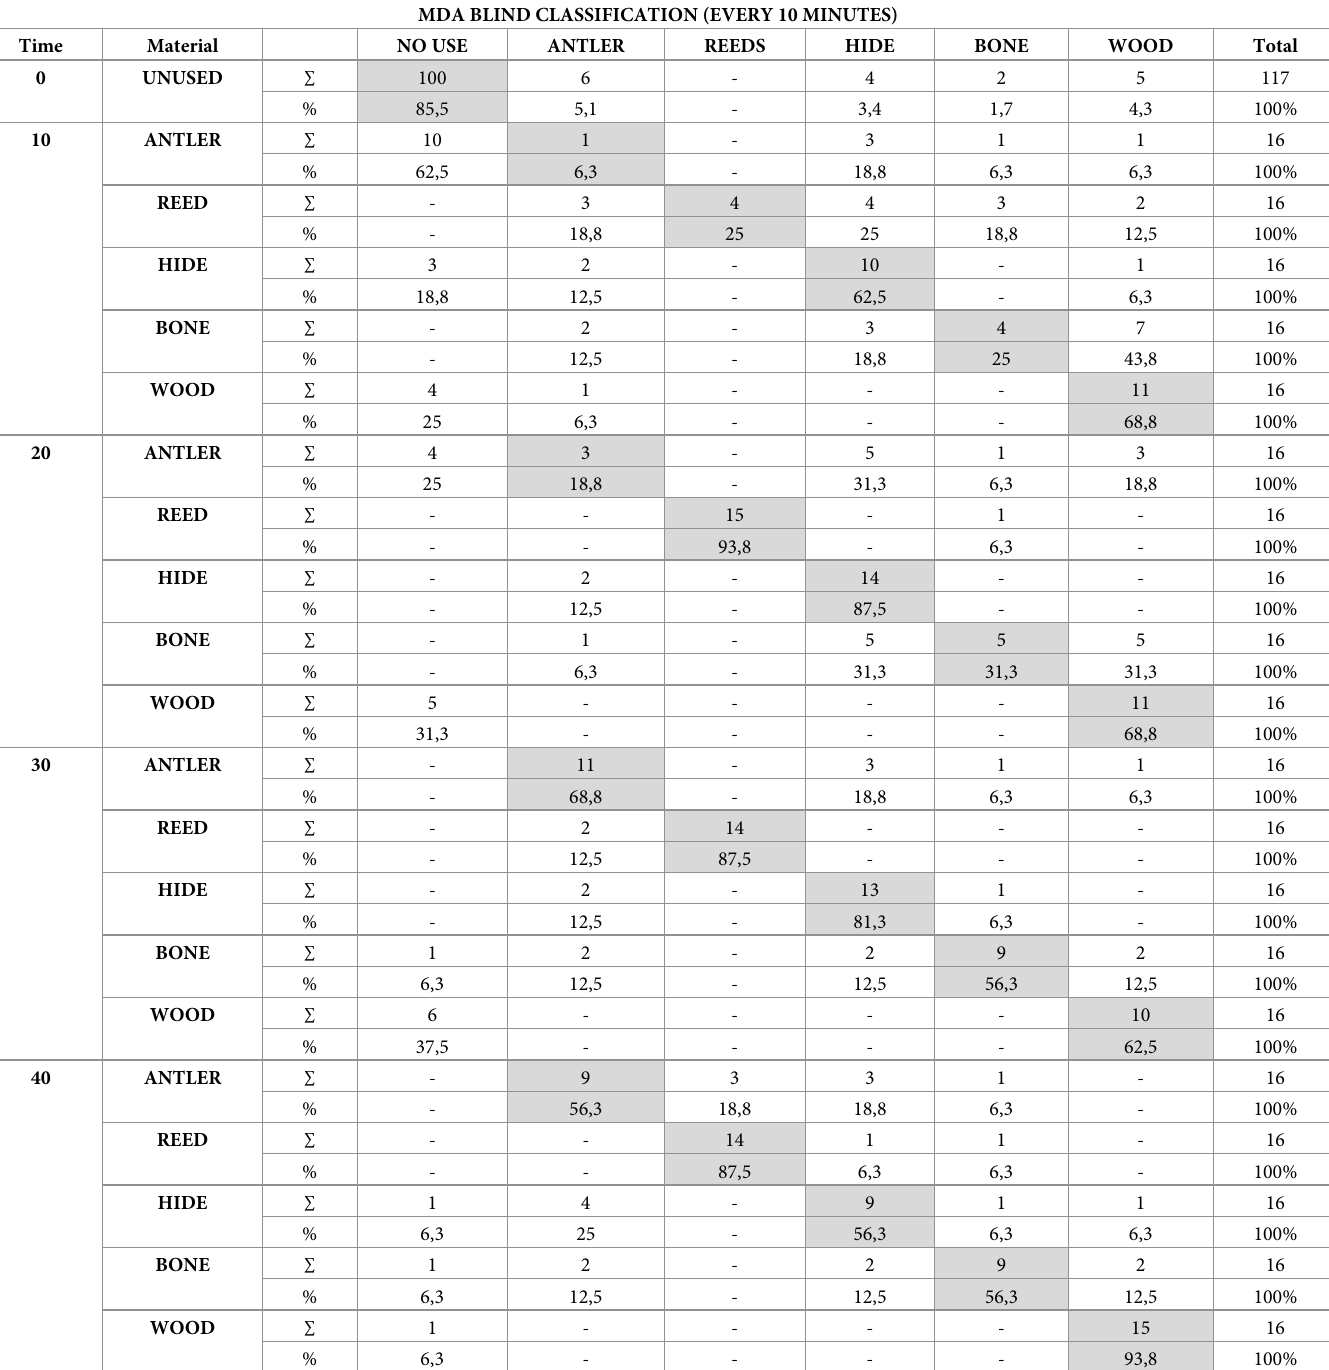
Table 5. Results of classification of the five worked materials (antler, reed, hide, bone and wood) every 10 minutes of use by quadratic discriminant analysis. Half of the surface samples (n = 8) of each group of worked material/time of use (i.e. bone 10 minutes, hide 20 minutes ... ) were blindly classified in the five groups of worked materials plus no use. Shaded cells indicate the correct